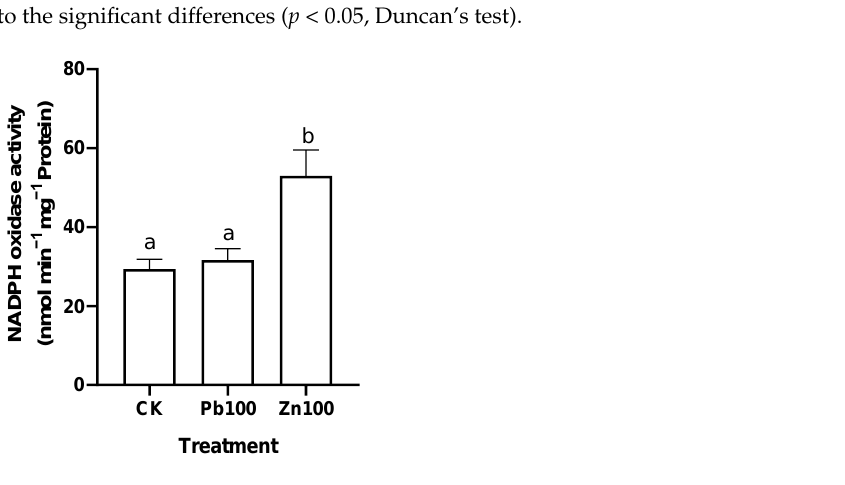
Figure 5. Activity of NADPH oxidase in roots of M. cordata grown hydroponically under control (CK), 100 µ mol · L − 1 Pb (Pb100) and Zn (Zn100) for seven days. Values are means ± SE ( n = 3) with three separate replicates. Means denoted by different letters refer to the significant differences ( p < 0.05, Duncan’s test).